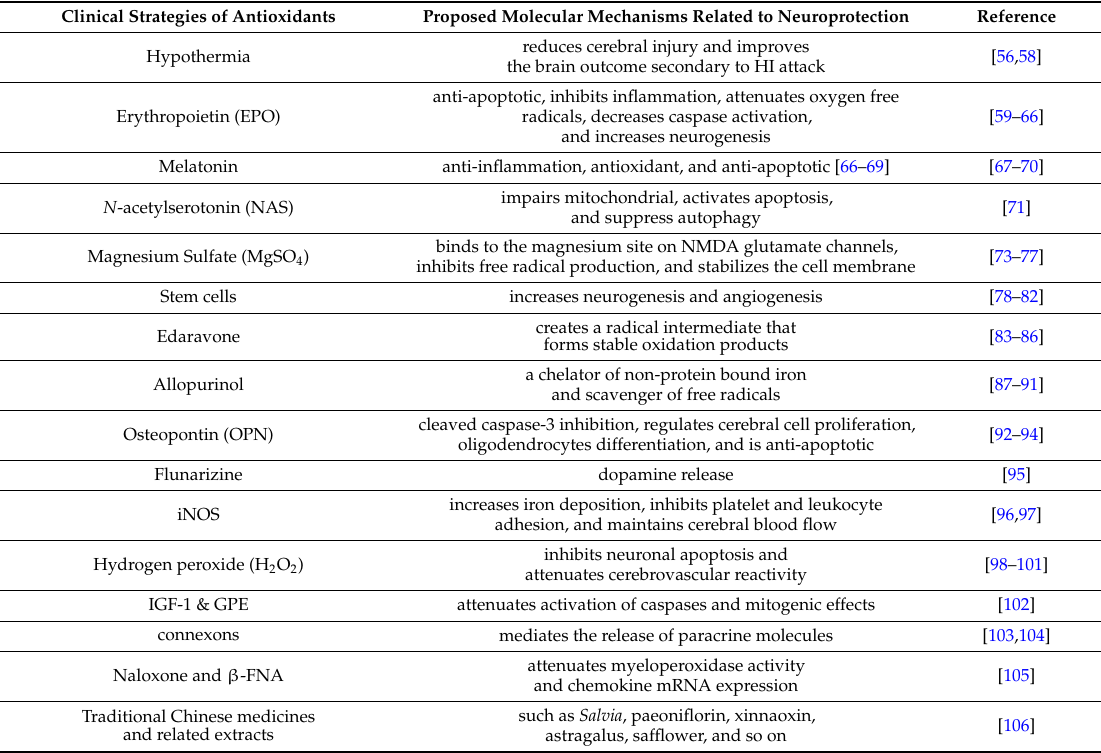
Table 1. Clinical strategies of antioxidants in HIE and their proposed molecular